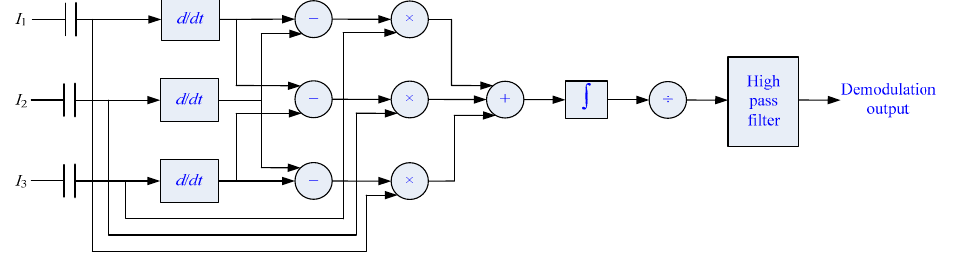
Fig. 2 Demodulation system based on the 3×3